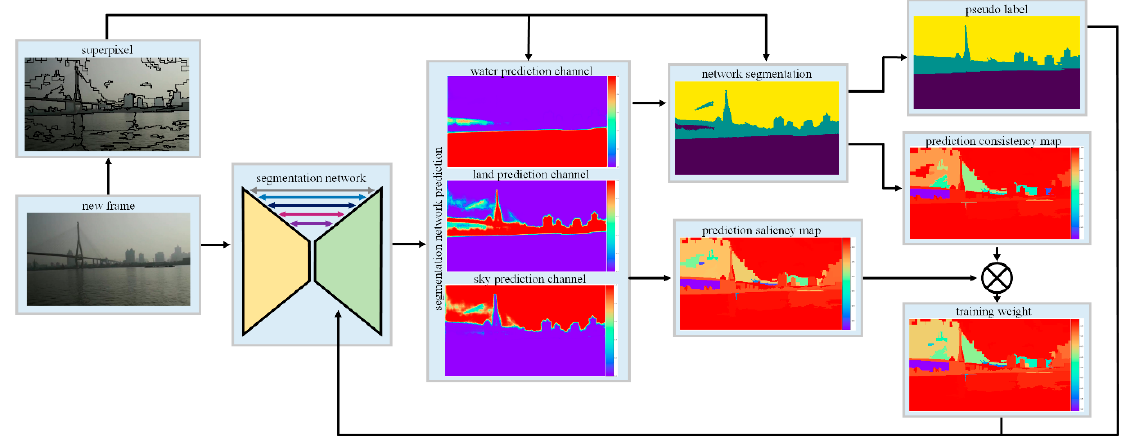
Figure 1. The diagram of the proposed method.